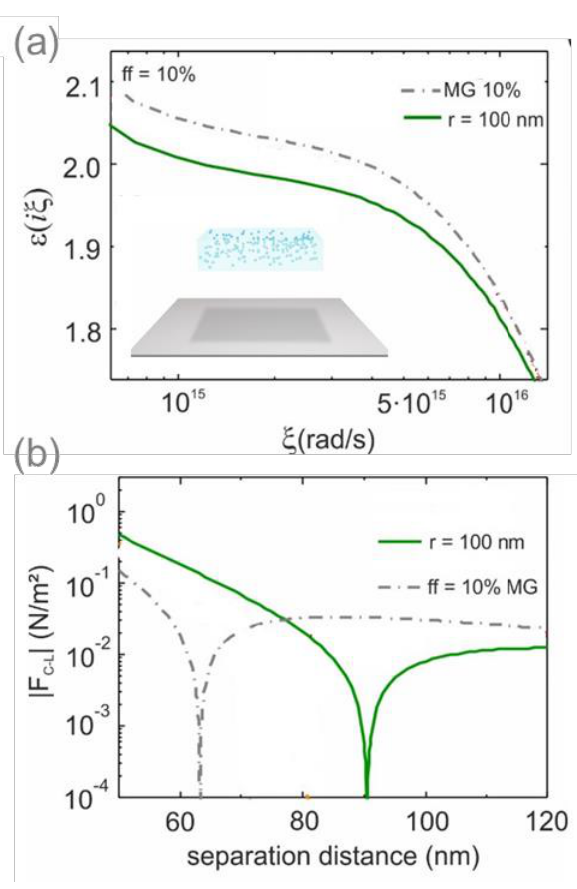
Fig. 2. (a) Effective dielectric function, evaluated at Matsubara frequencies, of a 1000 nm thick SiO2 film with PS nanospherical inclusions of radious r = 100 nm, in a 10% volume concentration (in green). For comparison, results attained using the Maxwell-Garnett effective medium approximation are shown in grey. (b) 𝐹 (𝐶−𝐿) attained for the same system as in panel (a), when the composite material is immersed in glycerol and faces a Si substrate. Results obtained with our novel approach and using the Maxwell-Garnett method are depicted in green and grey colors,